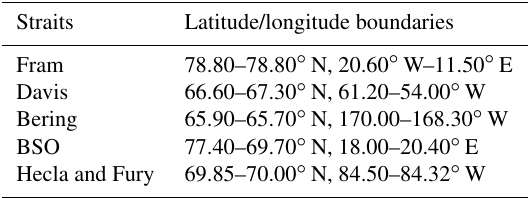
Table 3. Start and end points of the sections used for lateral flux calculations on the native ORCA